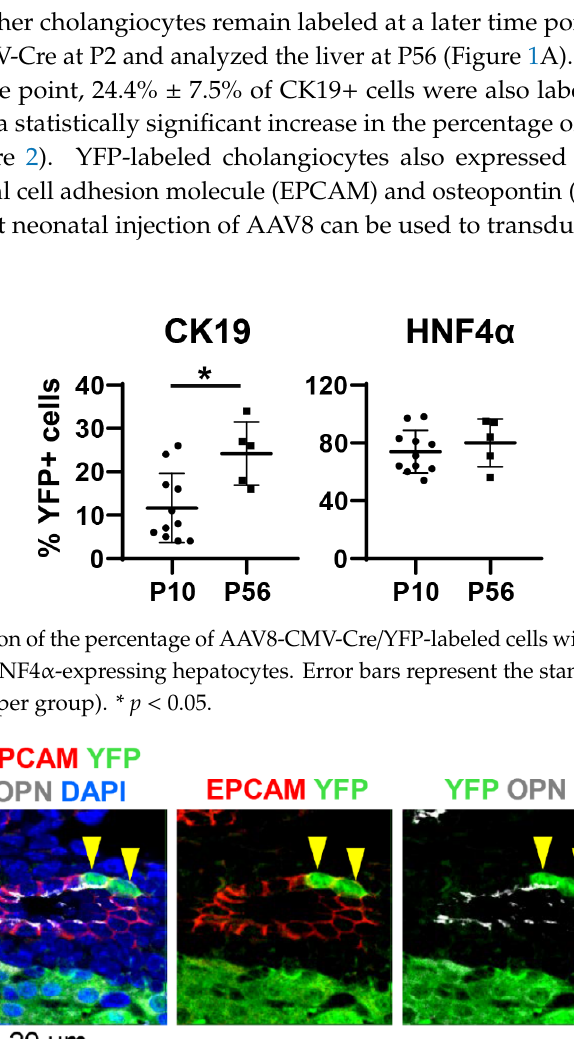
Figure 3. AAV8-CMV-Cre labels cholangiocytes expressing EPCAM and OPN. Rosa YFP/+ reporter mice were injected with AAV8-CMV-Cre at P2 and livers were analyzed at P10. OPN marks the apical surface of cholangiocytes. Yellow arrowheads: YFP+EPCAM+OPN+ cells.